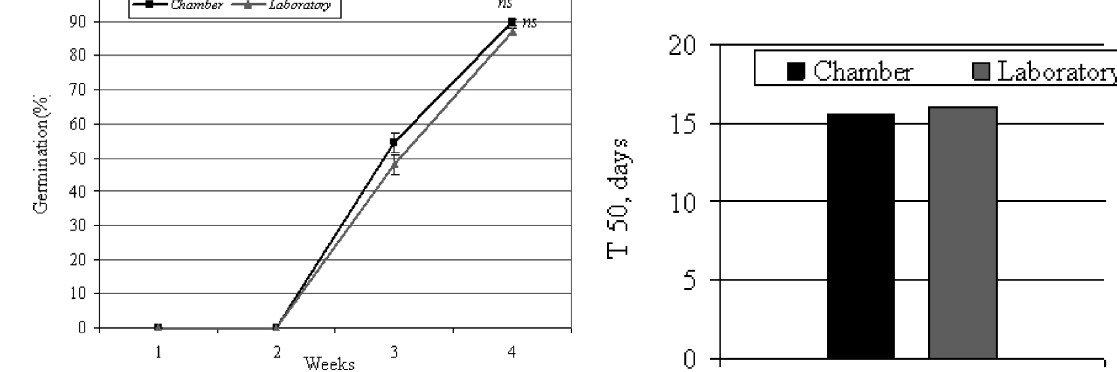
Figure 1. The germination percentage (weekly and total) in the two experiments.